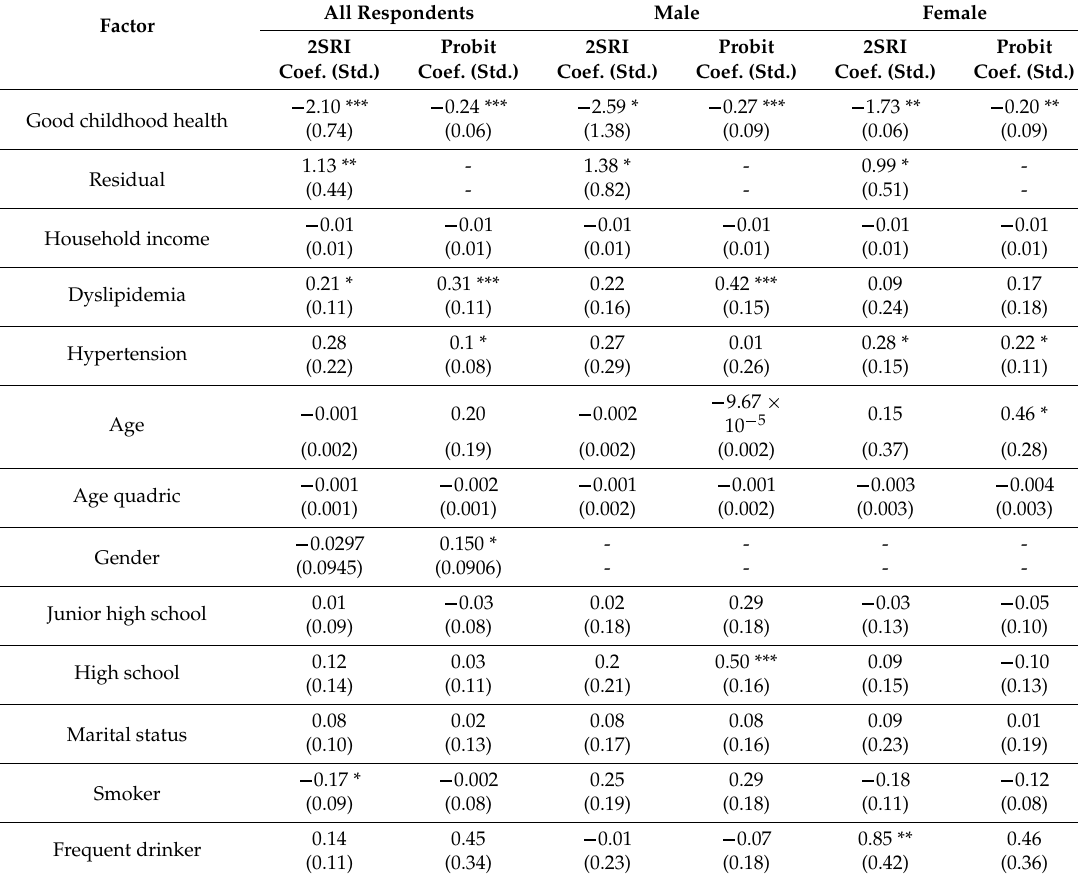
Table 2. The effects of childhood health status on adult cardiovascular